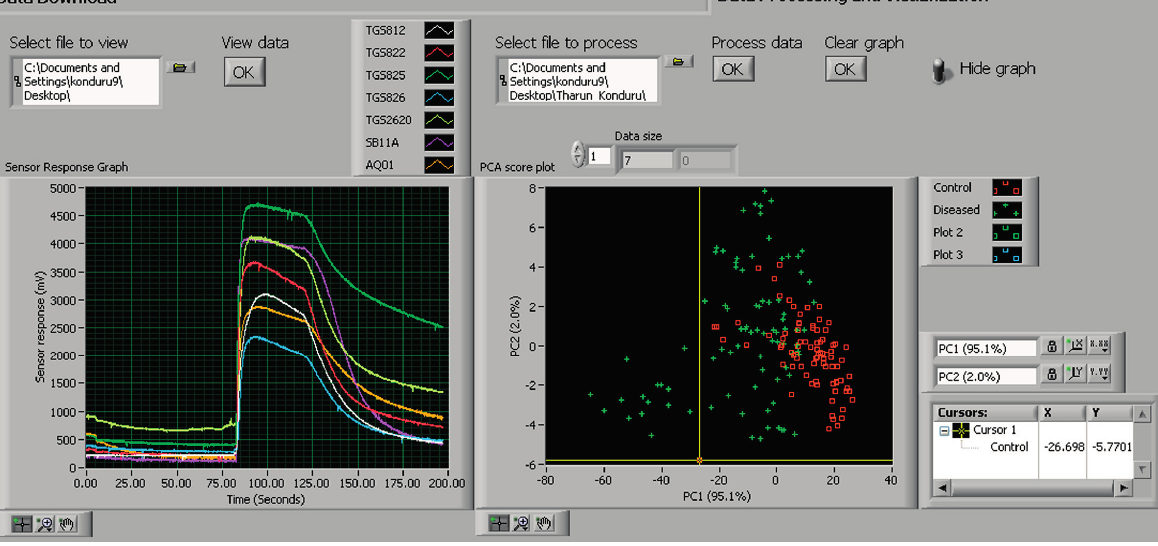
Figure 9. “Data processing and visualization” tab was used to view the collected data in the form of graphs (shown on the left side of the image). Principal component analysis was performed using GUI software. The PCA score plot was obtained along with the principal component